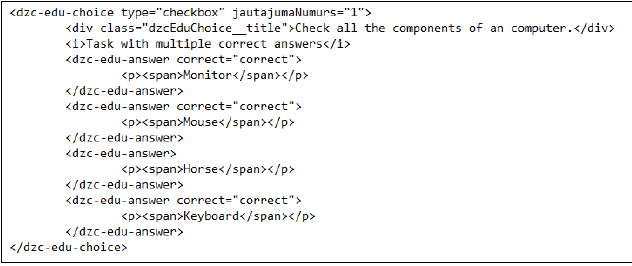
Fig. 3. Generated HTML5 code.